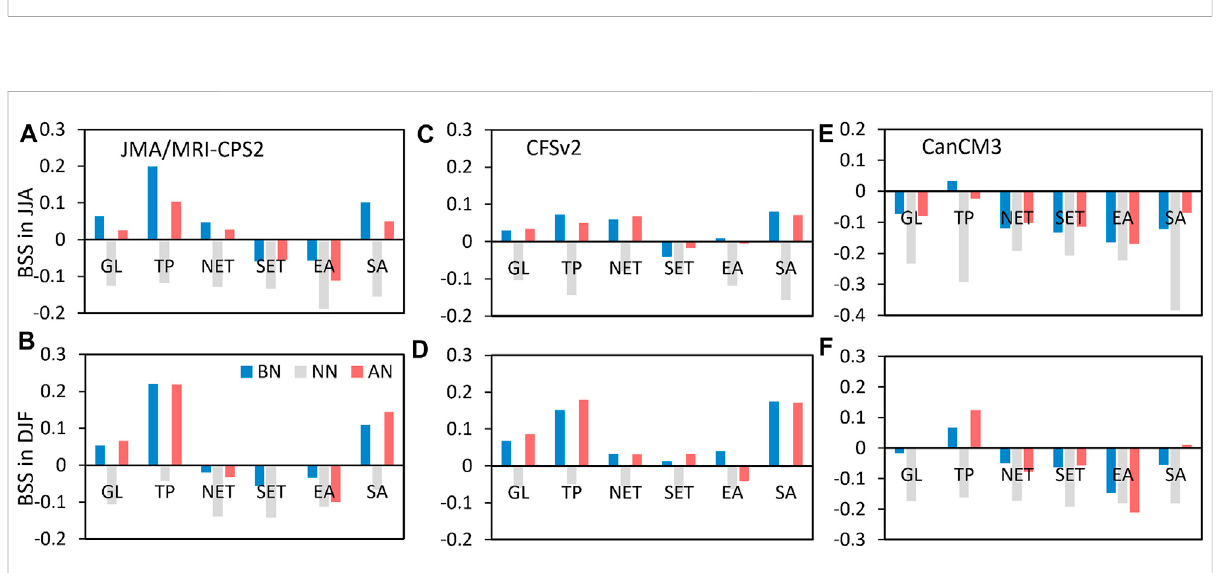
FIGURE 6 The area-averaged BSS in different regions for theabove normal (AN), near normal (NN) and below normal (BN) event for JMA/MRI-CPS2 (A,B) , CFSv2 (C,D) and CanCM3 (E,F) of temperature in JJA (upper panel) and DJF (below panel) season for the period 1982 –